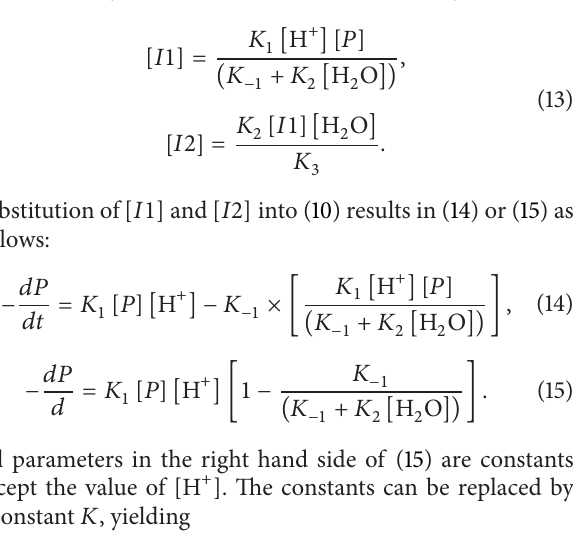
Figure 5: Average number of chain scissions, 𝛼 , as a function of HCl concentration at 65 ∘ C. Chitosan concentration was 1.0% and reaction time was